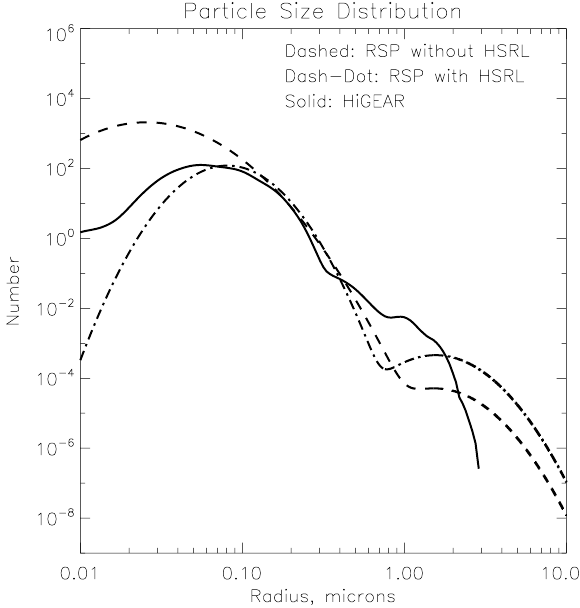
Fig. 6. This plot presents the retrieved and observed size distribu- tions for the segment in Fig. 5. RSP results for a failed optimization without HSRL have dashed lines, RSP results for a successful op- timization using HSRL data are represented as dash-dots, and the closest HiGEAR size distribution has a solid line. Because of the differences in sampling area, the HiGEAR data were normalized to the successful RSP size